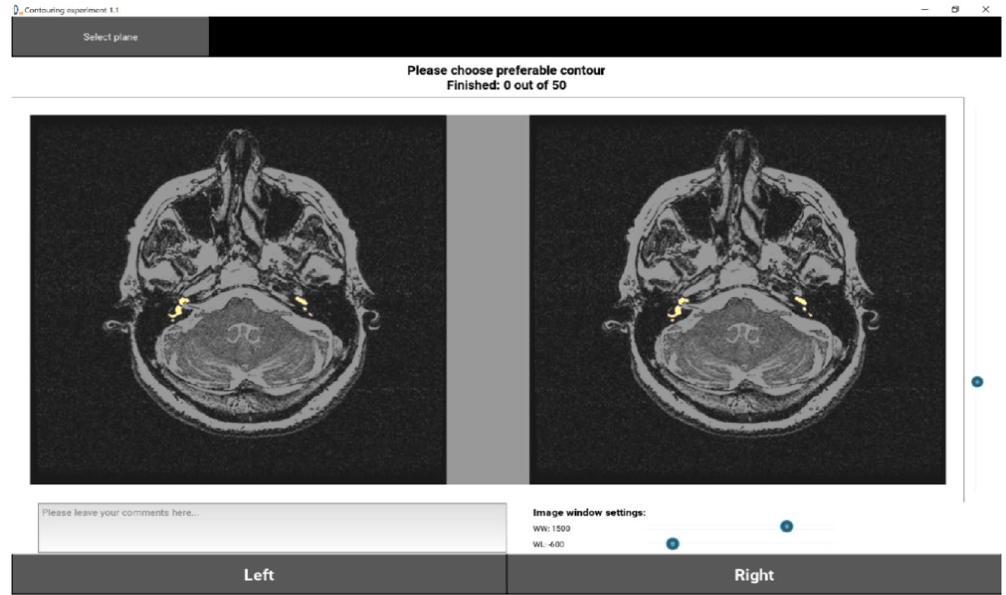
Figure 4. Example automated and manual segmentation overlaid on MRI volume as displayed by the software.